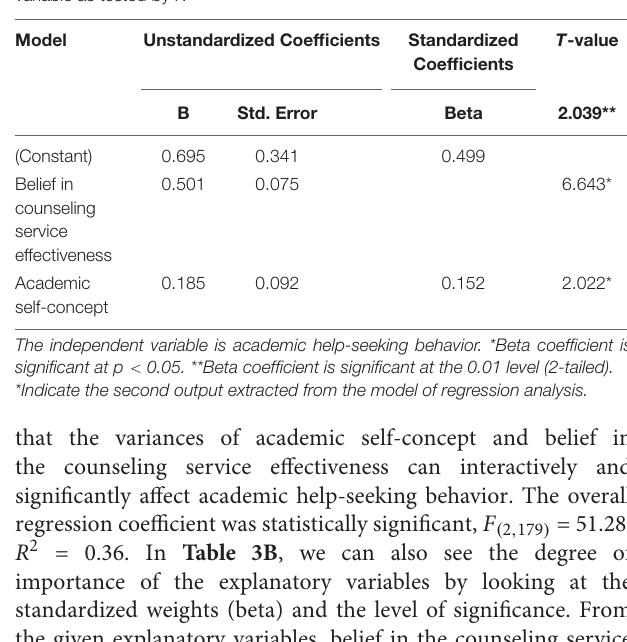
TABLE 3B | Model summary: Status of predictor variables on the criterion variable as tested by